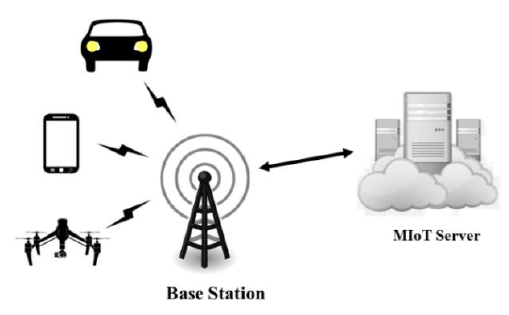
Figure 1. Scenario of the MIoT system.